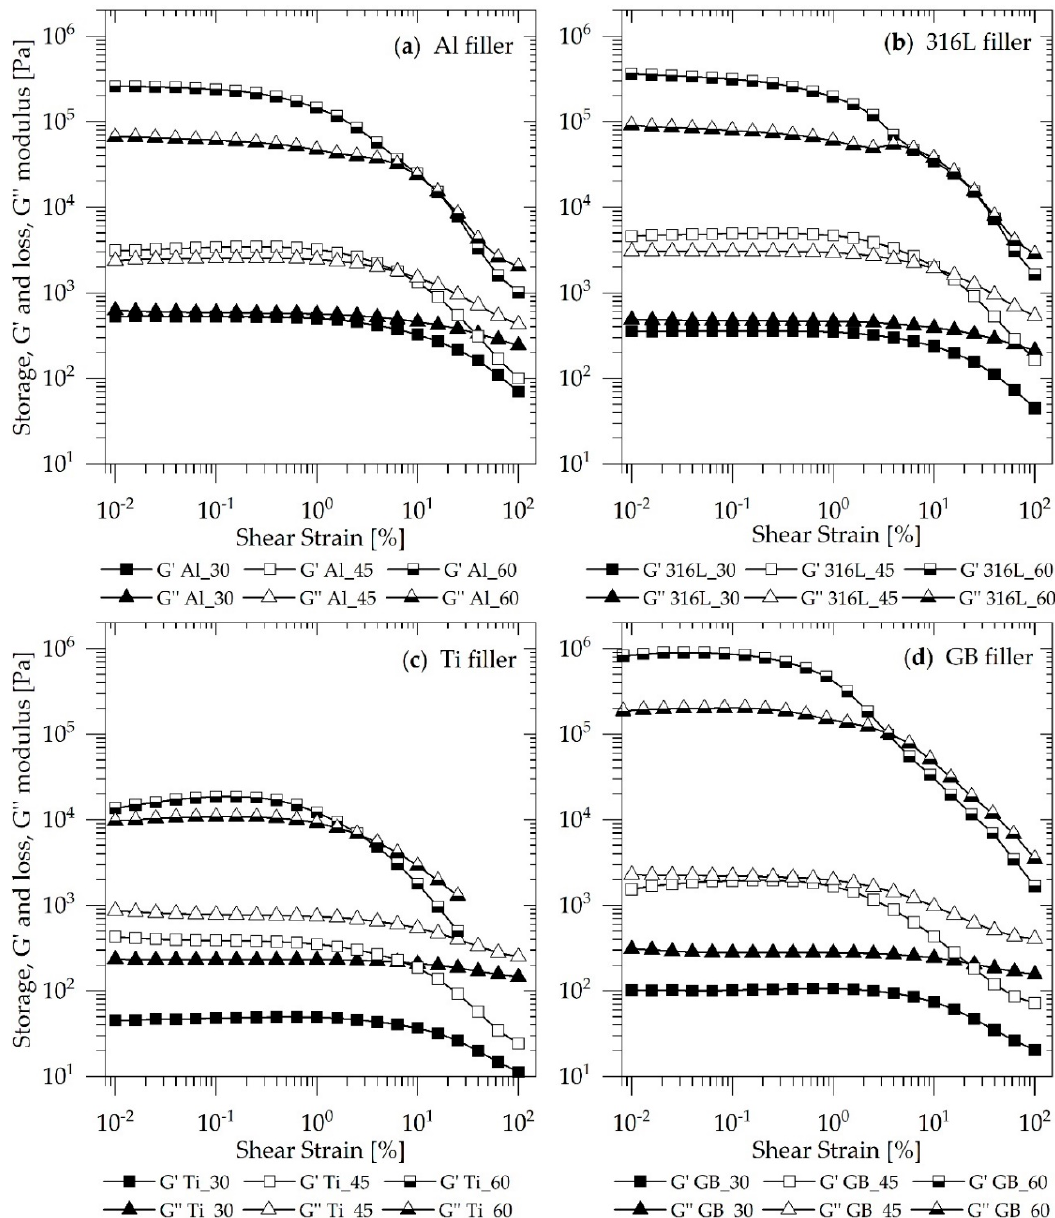
Figure 3. The effect of filler concentration on storage, G ′ and loss, G ″ modulus as a function of shear Figure 3. The e ff ect of filler concentration on storage, G (cid:48) and loss, G” modulus as a function of shear strain for the fillers: ( a ) Al, ( b ) 316L, ( c ) Ti, and ( d ) GB at 175 °C. strain for the fillers: ( a ) Al, ( b ) 316L, ( c ) Ti, and ( d ) GB at 175 ◦